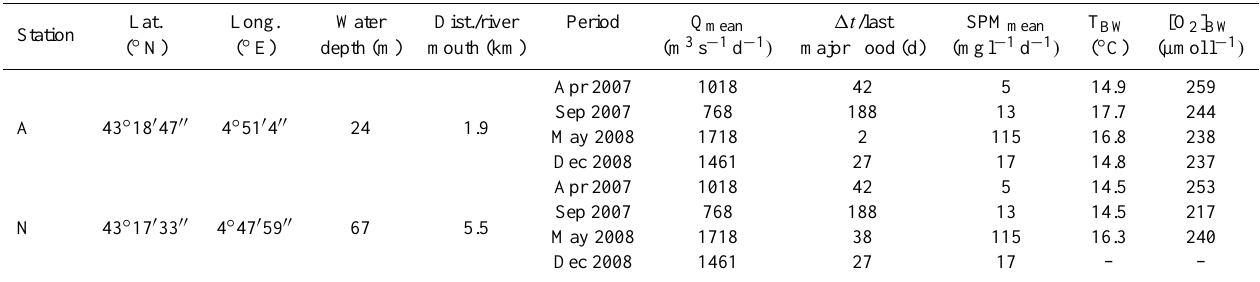
Table 1. Location and environmental characteristics of both Stations A and N over the four sampling campaigns. Q mean and SPM mean are mean Rhˆone River discharge and suspended material load, respectively, calculated over the 15 days prior to sampling. 1t /last major flood is the time interval since the last Rhˆone River flood > 3000m 3 s − 1 . T BW and [O 2 ] BW correspond to bottom water temperature and oxygenation,